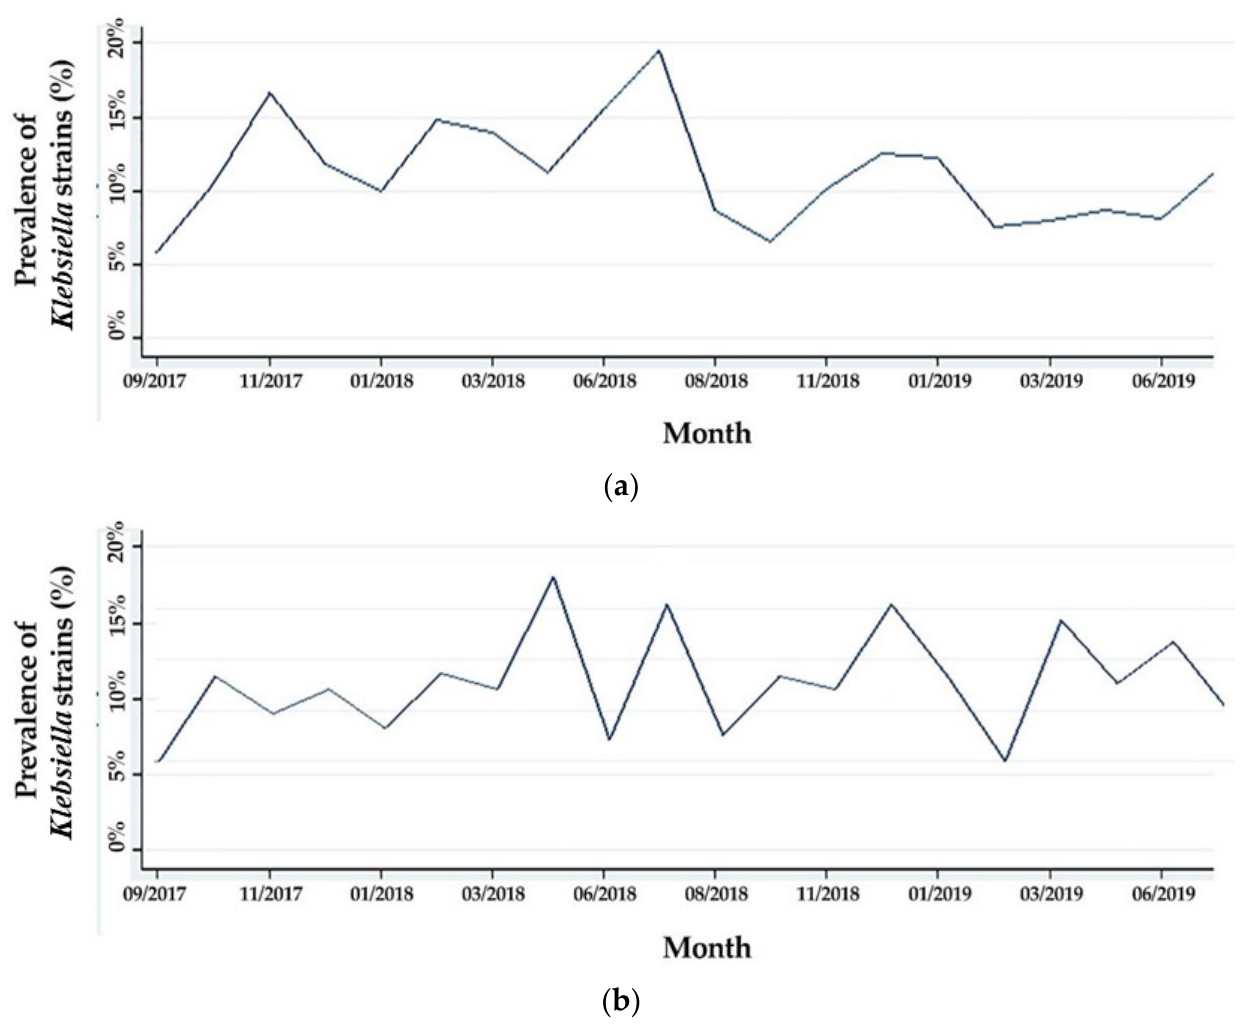
Figure 2. Evolution of the incidence of Klebsiella strains: ( a ) in the surgical wards; ( b ) in medical wards.